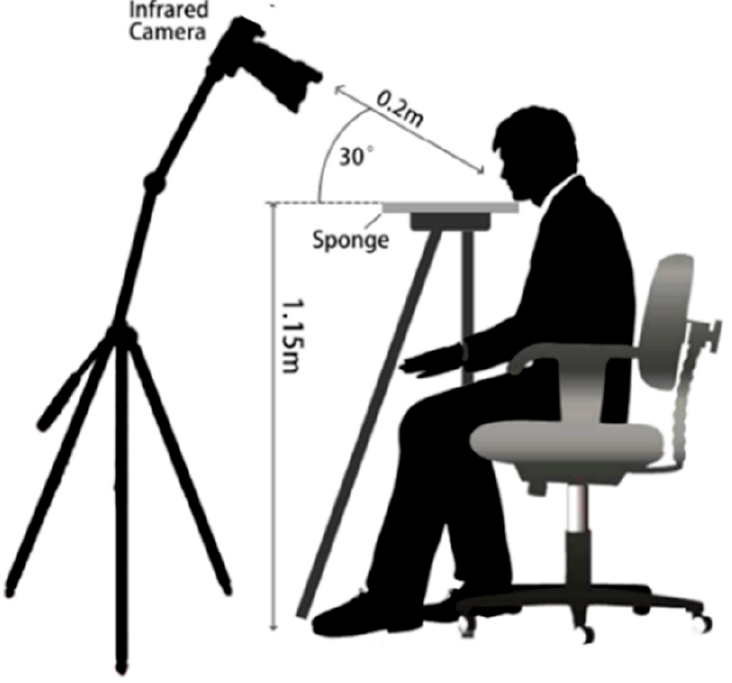
Figure 1. Sketch of thermography experiment for human subjects.